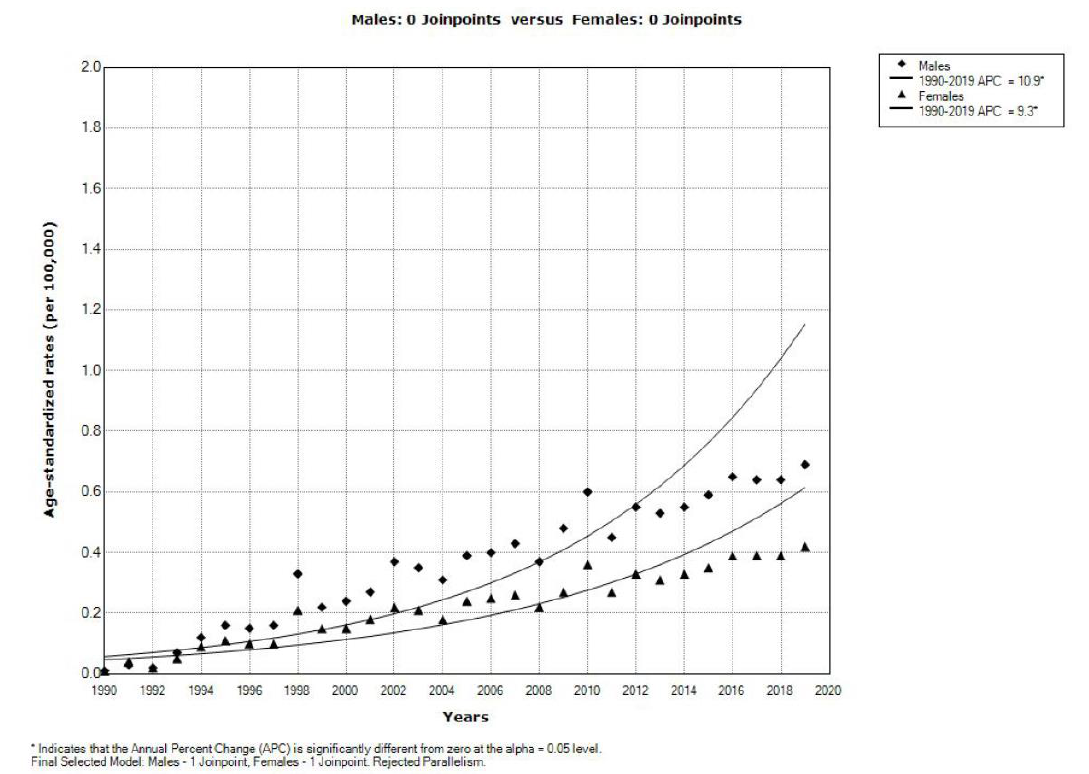
Figure 2. Global ischemic heart disease mortality rates (per 100,000 person) attributed to high temperature, by sex, 1990–2019; a joinpoint regression analysis.